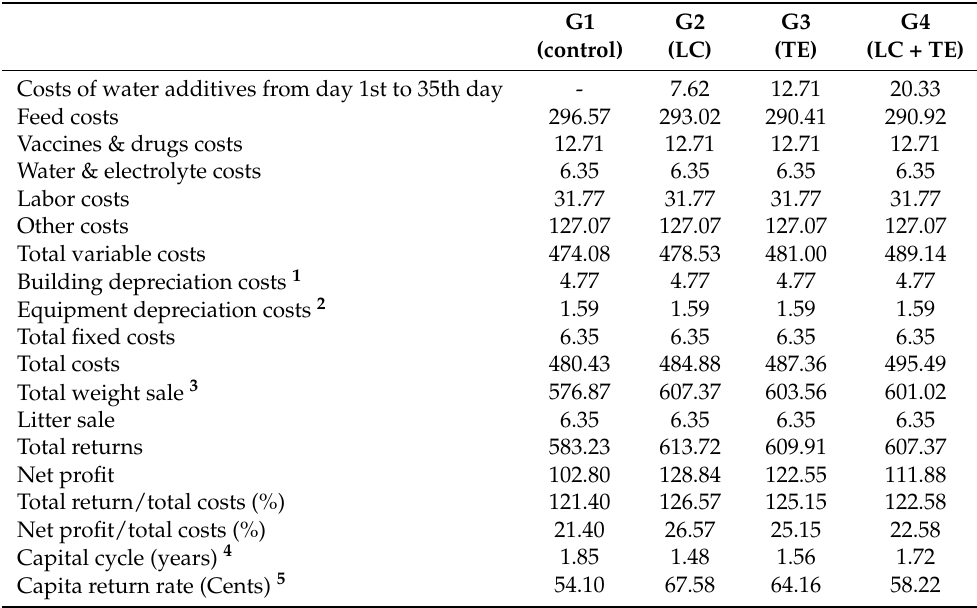
Table 6. Effect L-Carnitine and/or calf thymus extract supplementation on * economic parameters traits ($) in Japanese quail (September